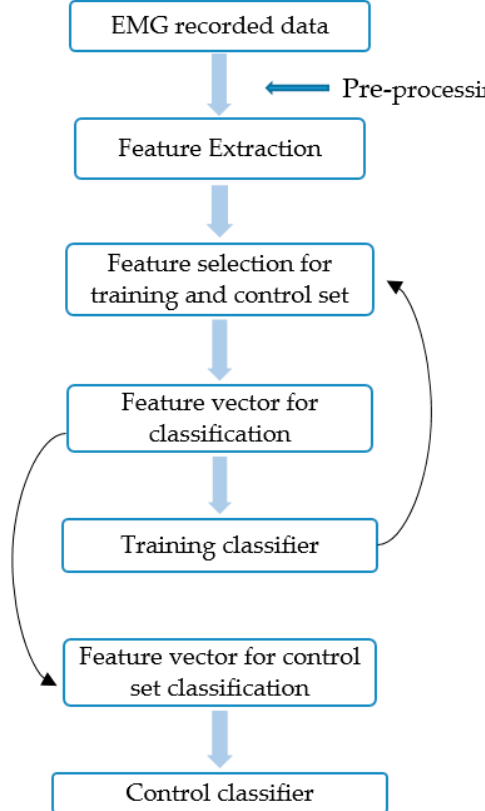
Figure 2. General pattern followed by the EMG-PR for real-time collected data from amputee.